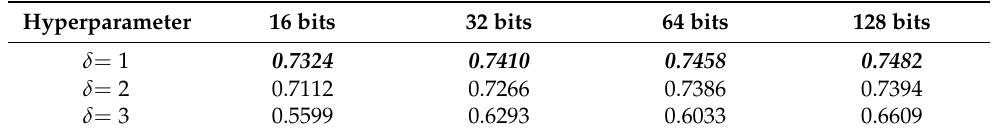
Table 3. mAP with different hyperparameters.